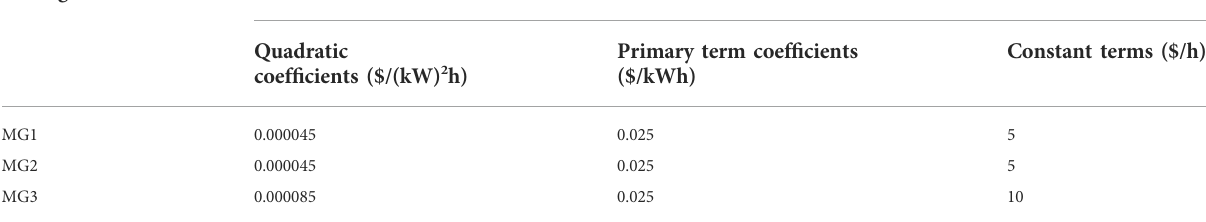
TABLE 1 Power generation costs of three